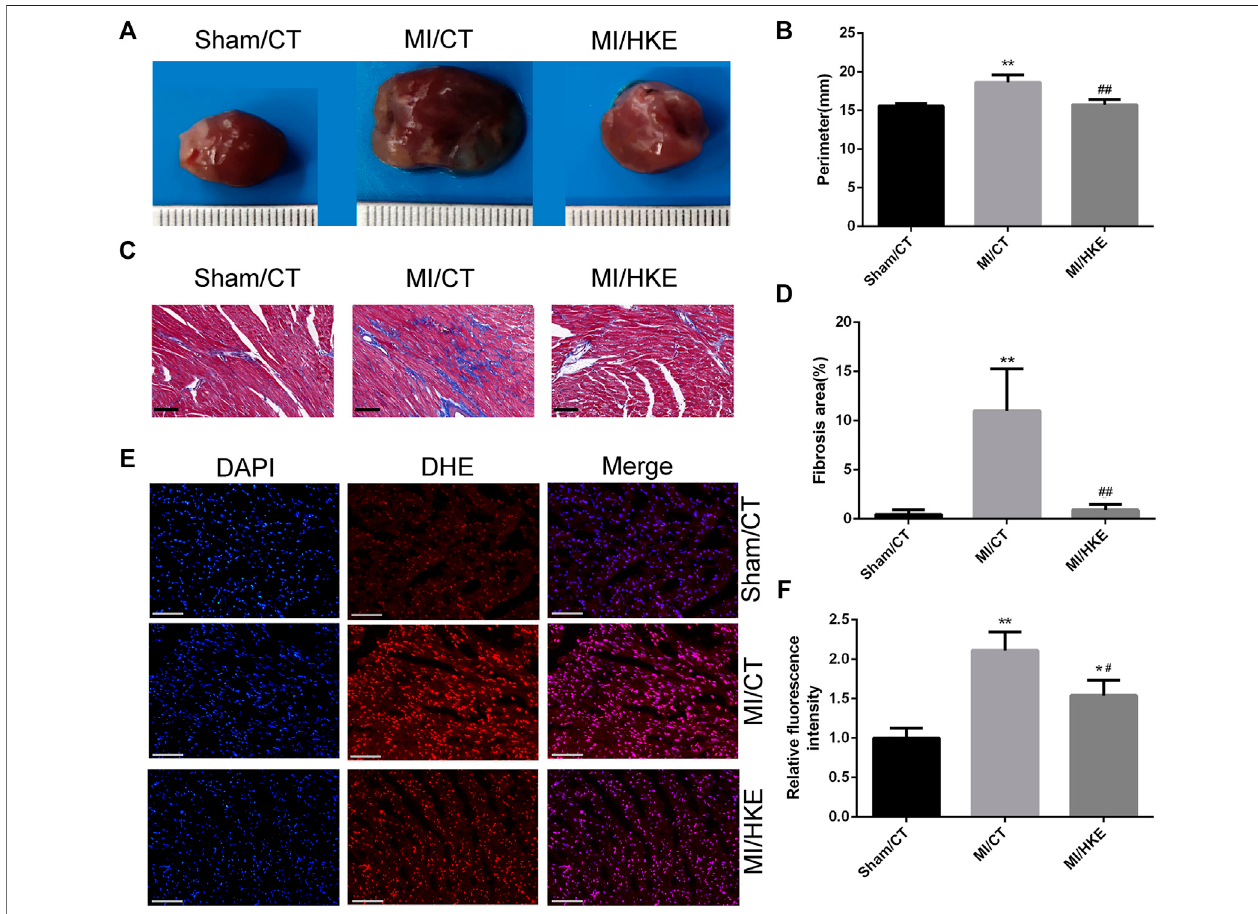
FIGURE2| HKEinhibitsmyocardialremodeling,reducestheROS,andalleviatesmyocardial fi brosis invitro .TypicalheartappearanceingroupsSham/CT,MI/CT, and MI/HKE (A) . The perimeter of the largest part cross section of the heart was measured to evaluate myocardial remodeling (B) . Masson ’ s Trichrome staining was conducted to evaluate myocardial fi brosis, the fi brotic area was indicated as a blue region, the red frame encircles the fi brosis away from the infarct area in the MI group and similar locations in other groups, scale bar: 50 μ m (C) . The fi brosis of red frame area was measured using ImageJ software (D) (n = 3 per group). Heart slides were stained with DHE to analyze the production of ROS in situ , scale bar: 100 μ m (E) . The fl uorescence intensity was measured using ImageJ software (F) ( n = 3 per group). Values are shown as means ± SD, *p < 0.05, **p < 0.01 vs. Sham/CT group or control, # p < 0.05, ## p < 0.01 vs. MI/CT.